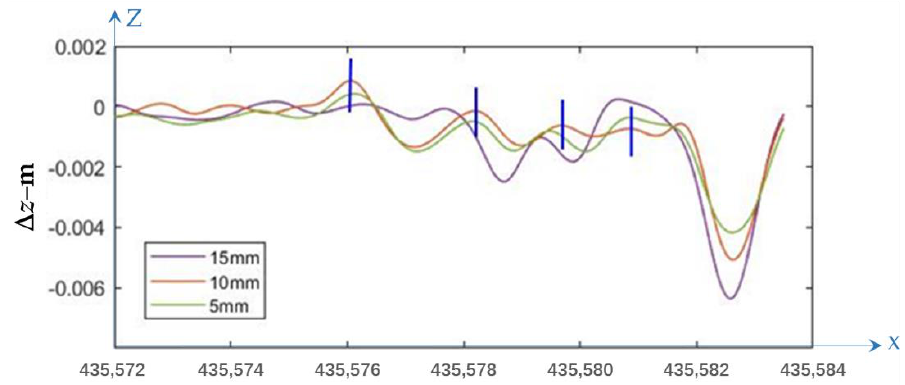
Figure 19. Height difference results (profile through one board center,